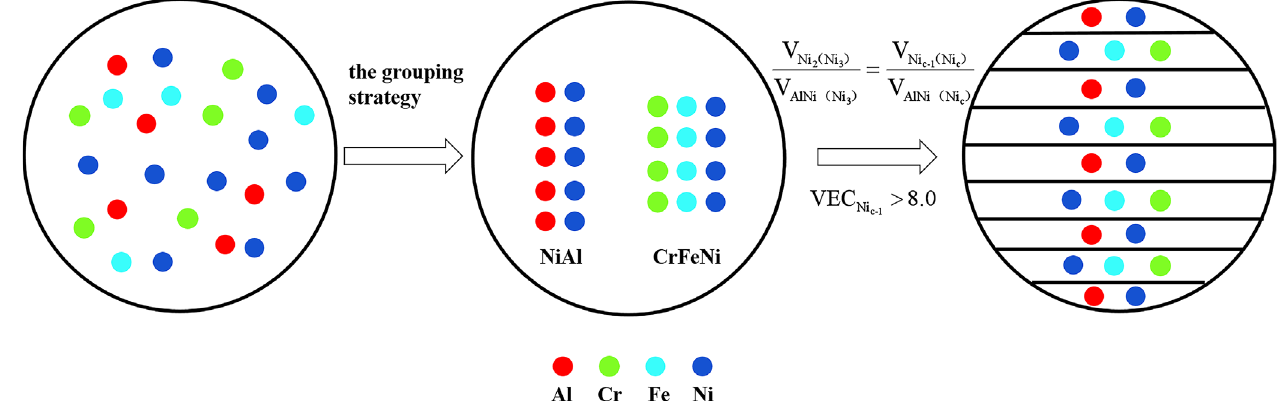
Figure 1. Schematic diagram of alloy design idea. Table 1. Physiochemical properties for the used elements (from the periodic table software).